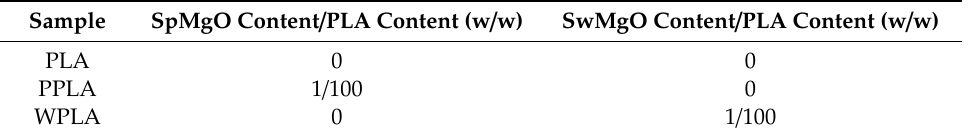
Table 1. Detailed information of the